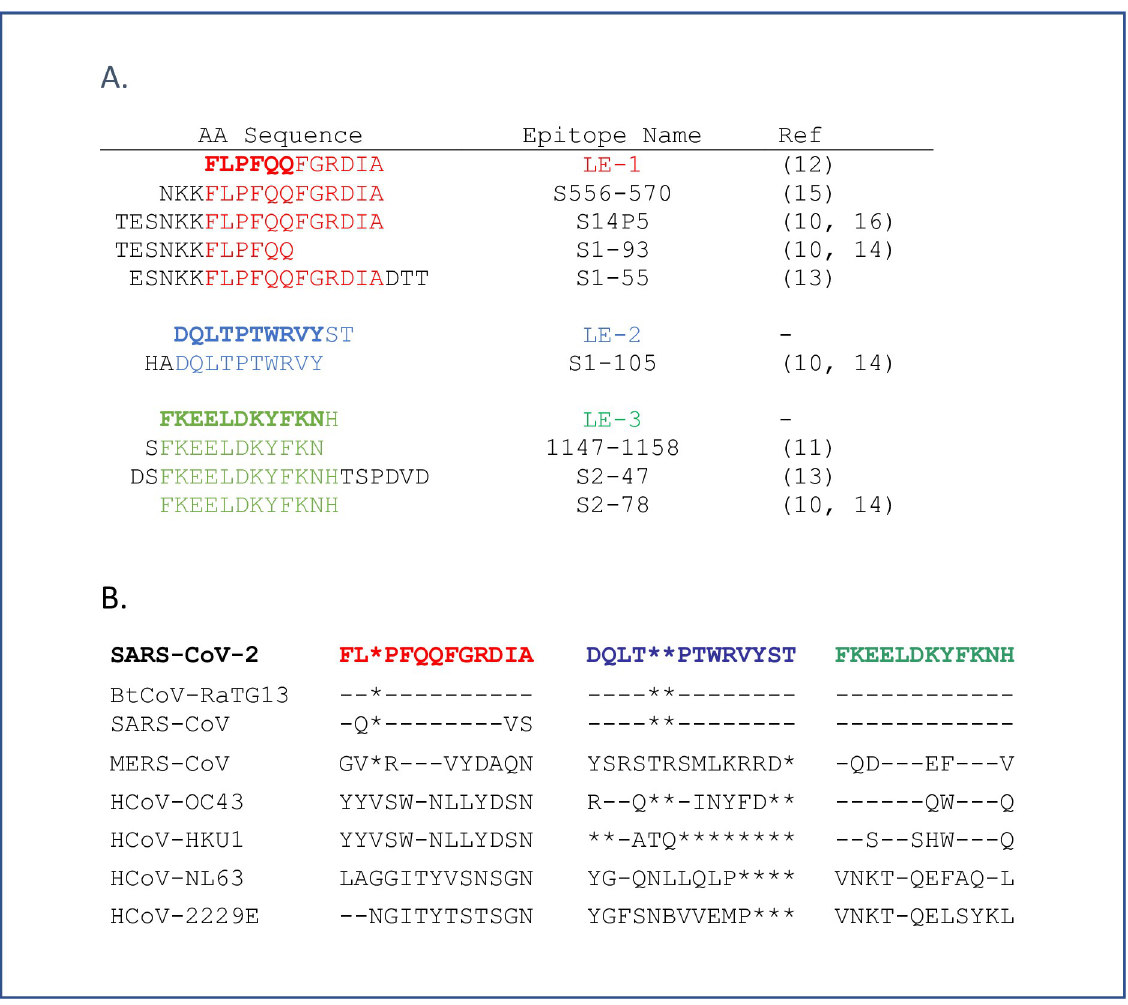
Fig 3. Alignment of dominant linear vaccine epitopes with those induced by infection and in other coronaviruses. Alignment of vaccine epitopes with those previously described in natural SARS-CoV-2 infection (A). Alignment of vaccine epitopes with homologous regions in other coronaviruses (B). � are spaces included to maximize